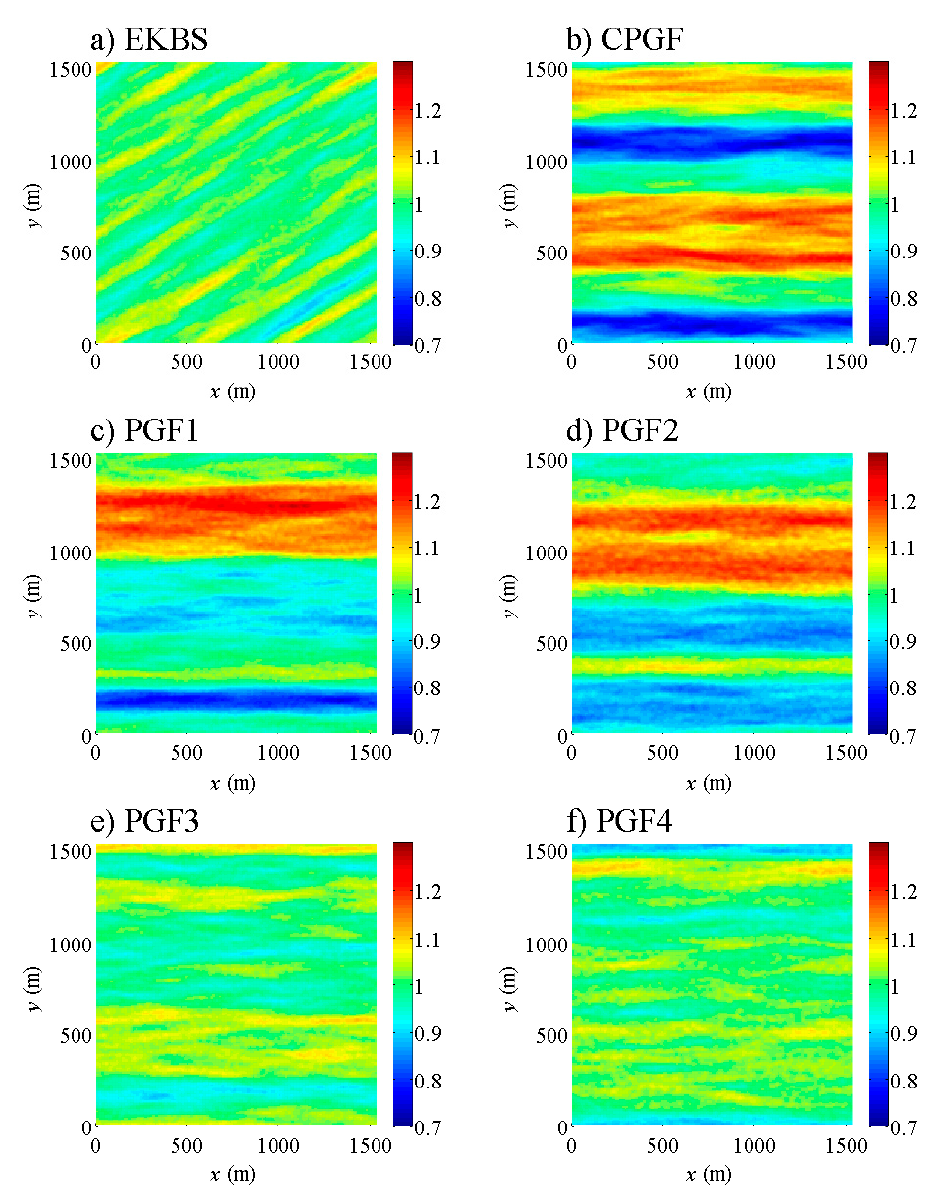
Figure 8. One-hour-averaged horizontal wind velocities on a horizontal plane at z = 56 m for the boundary-layer simulations (1568 m × 1568 m × 800 m): ( a ) EKBS; ( b ) CPGF; ( c ) PGF1; ( d ) PGF2; ( e ) PGF3; ( f ) PGF4. For each simulation, wind velocities are normalized by the mean wind velocity at z = 56 m.